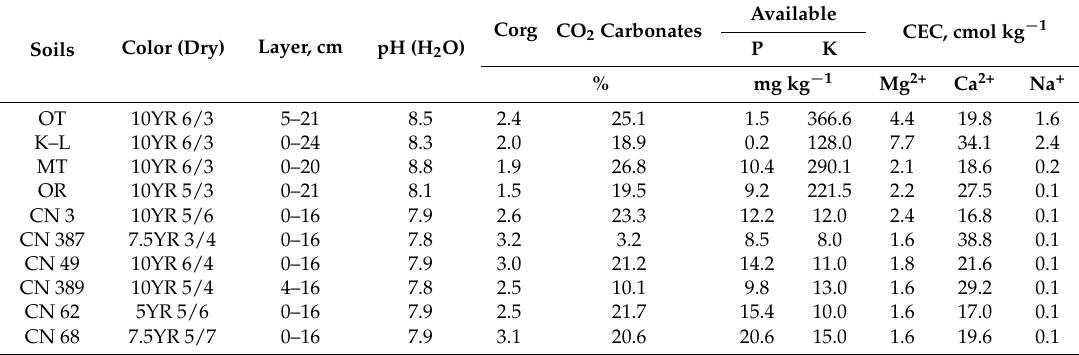
Table 4. Agrochemical properties of soils in deposits on the antique vineyards of the near (CN) and distant districts of